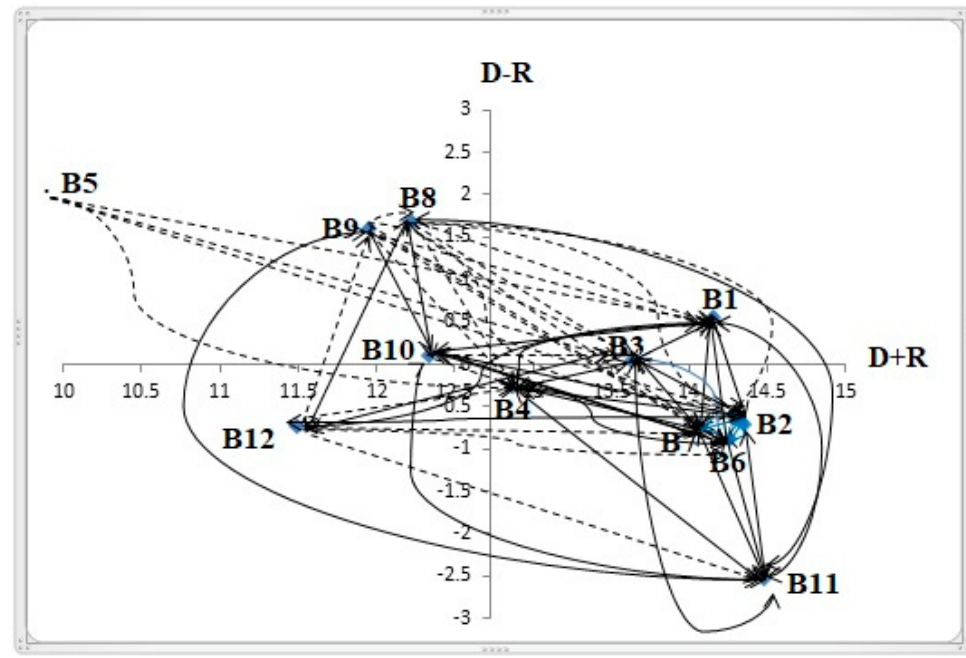
Figure 3. Causal inter-relationships of CE barriers.